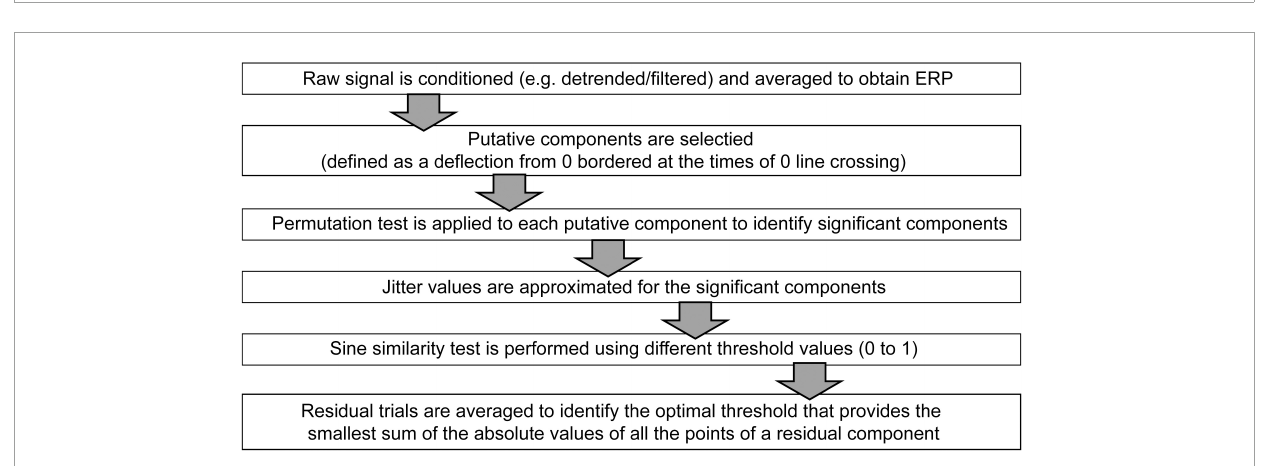
FIGURE6 Workflow diagram of the